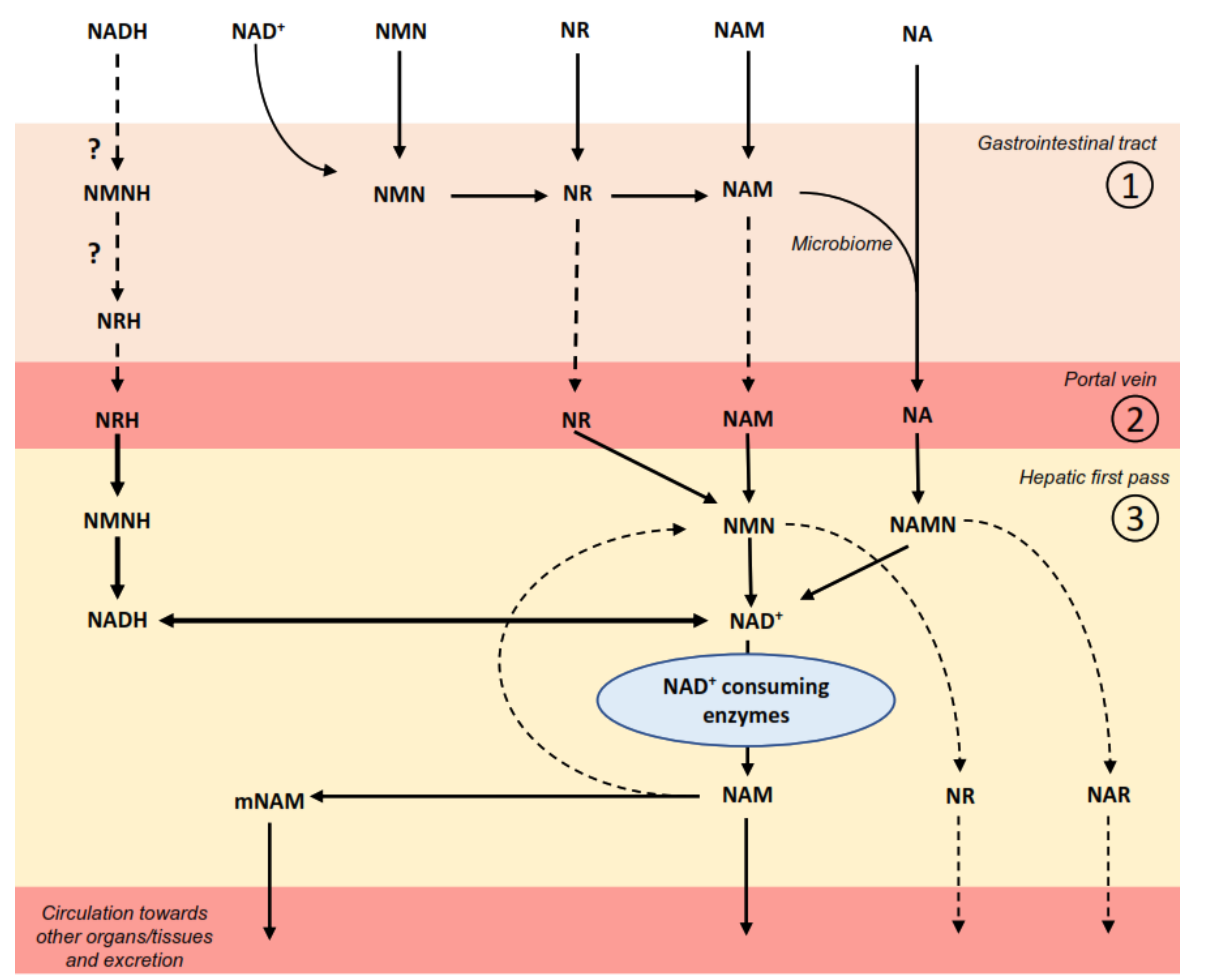
Figure 2. NAD + metabolism after oral administration: The NAD backbone is mostly obtained